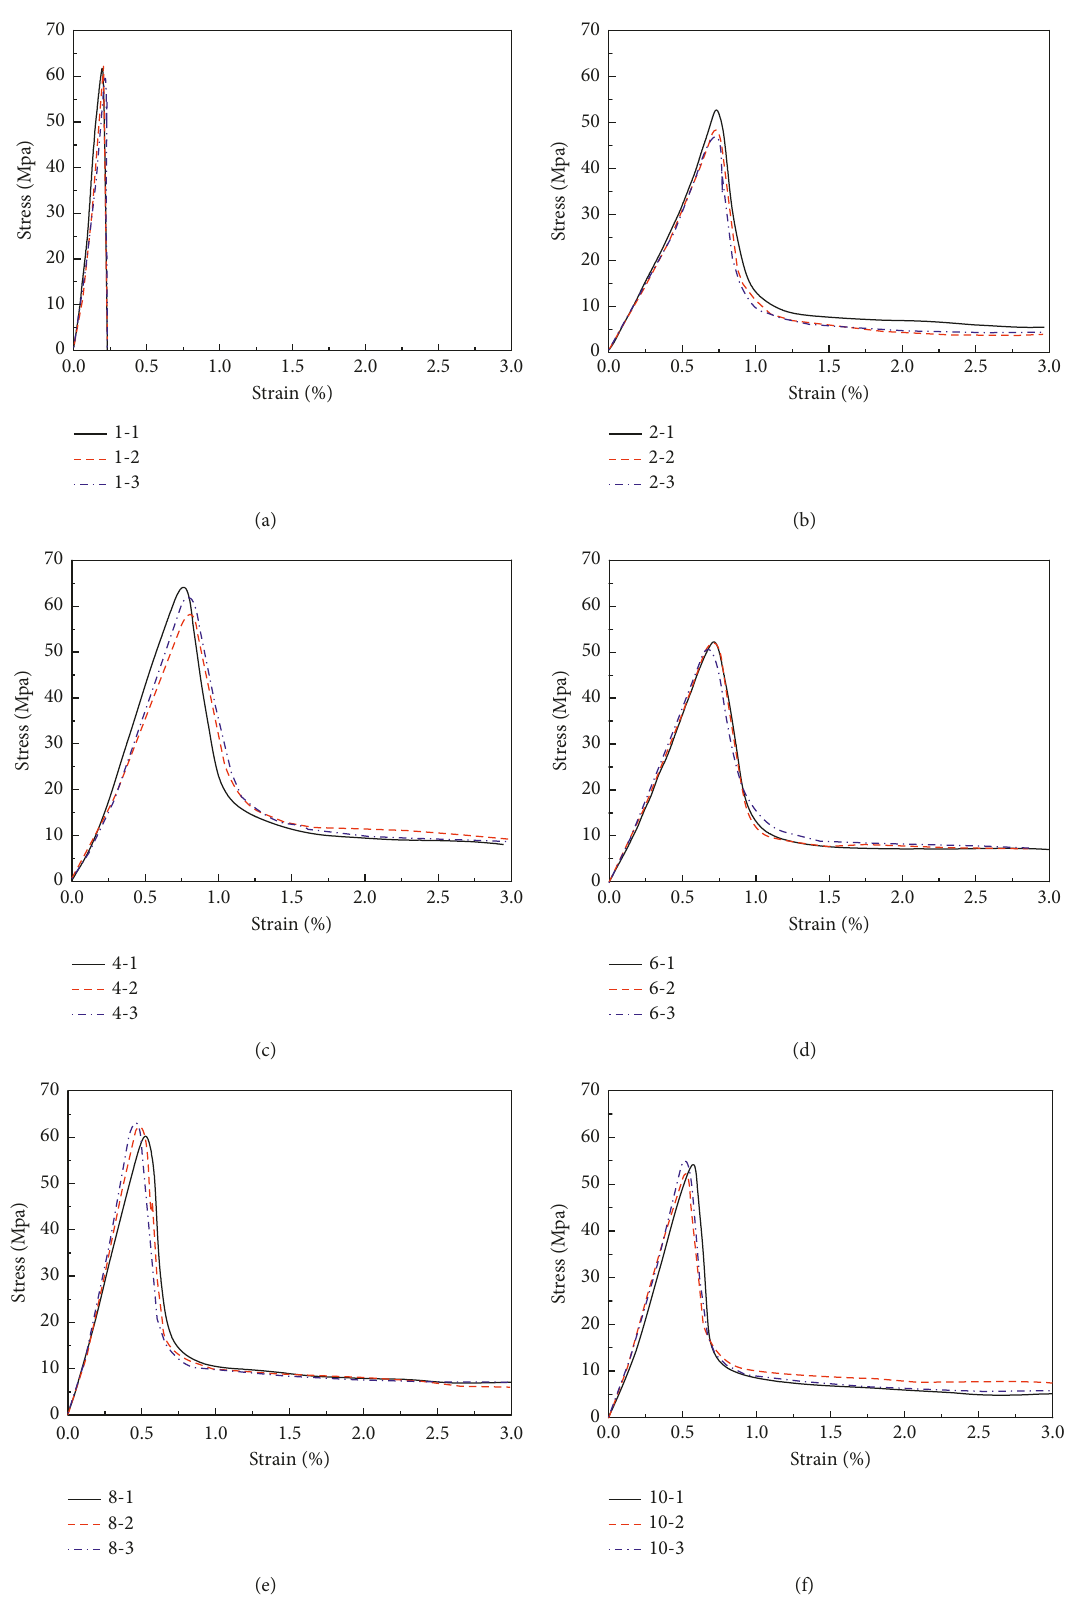
Figure 4: Typical uniaxial compression stress-strain curves of HDC. (a) Matrix, (b) HDC-2, (c) HDC-4, (d) HDC-6, (e) HDC-8, and (f)